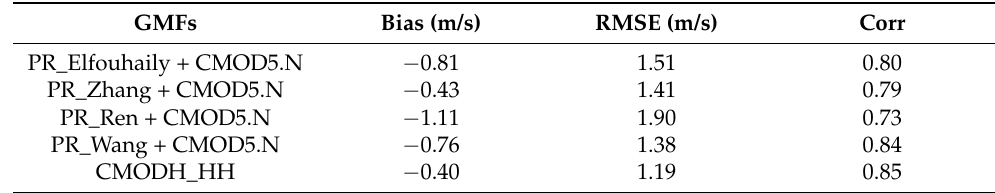
Table 4. Comparison of wind speed retrieval results of the GF3-02 HH polarization data based on each GMF model and ERA5 wind data. GMFs Bias (m/s) RMSE (m/s)